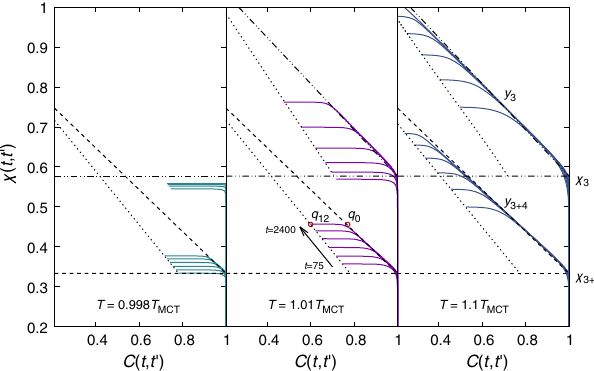
FIG. 6. Integrated response χ ð t; t 0 Þ versus correlation C ð t; t 0 Þ for 0 . 998 , 1.01, 1.1. three different initial temperatures T=T MCT ¼ The lines are plotted by fixing (from bottom to top) t ¼ 75 , 150, 300, 600, 1200, 2400 and changing t 0 . In all the panels, upper data are for the three-spin model, and lower data are for the ( 3 þ 4 )- FIG. 5. Decay of the radial reaction with time in the ( 3 þ 4 )- spin model. The dash-dotted/dotted lines indicate the suscep- spin model on a double logarithmic scale. Its asymptotic value is tibility χ and the fluctuation dissipation ratio y 0 predicted by 6 for T ≥ T 6 mg compatible with μ and goes above μ mg ¼ SF mg ¼ the memoryless solution. It is interesting to note that in the . This result proves that dynamics tends towards for T < T SF ( 3 þ 4 )-spin model, the dynamics does not have any appreciable marginal minima for T > T . SF change at T , while in the three-spin model, starting below MCT T , the system remains trapped in a MCT